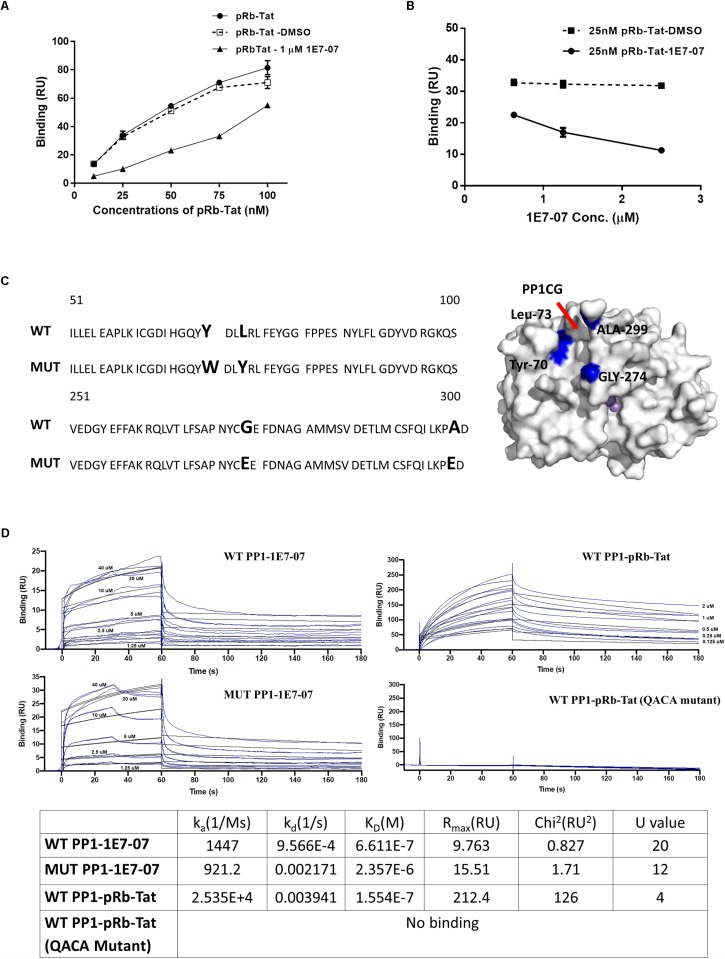
Validation of 1E7-07’s major binding sites on PP1 by SPR. Binding of 1E7-07 to recombinant wild type (WT) or Mutated (MUT) PP1 measured by surface plasmon resonance (SPR). (A) Binding competition assay with pRb-Tat peptide for binding to PP1. Different concentrations of pRb-Tat hybrid peptide (10–100 nM) were prepared in a running buffer that contained 1 μM 1E7-07 or DMSO. (B) The experiment in (A) was repeated by adding different concentrations (0.625–2.5 μM) of 1E7-07 to the running buffer and 25 nM of pRb-Tat peptide binding to PP1 was measured. (C) PP1 was mutated in the C-terminal groove to generate Y73W, L73Y, G274E, and A299E mutant. The sequence alignment of WT PP1 and MUT PP1 is shown. The mutation residues on the PP1CG site are also mapped on the surface of PP1 in blue (right panel). (D) Binding affinities of 1E7-07 interaction with WT PP1 and MUT PP1 were measured. pRb-Tat and pRb-Tat with QACA mutation were used as a positive and negative control, respectively. X axis represents time in seconds and Y axis shows binding in resonance units. Each line represents a different concentration of 1E7-07 (0–40 μM). Colored lines are the actual data; black lines are the curve fit that was used to calculate kinetics values. Each concentration was run two times. The binding parameters including ka, kD, and KD are shown.